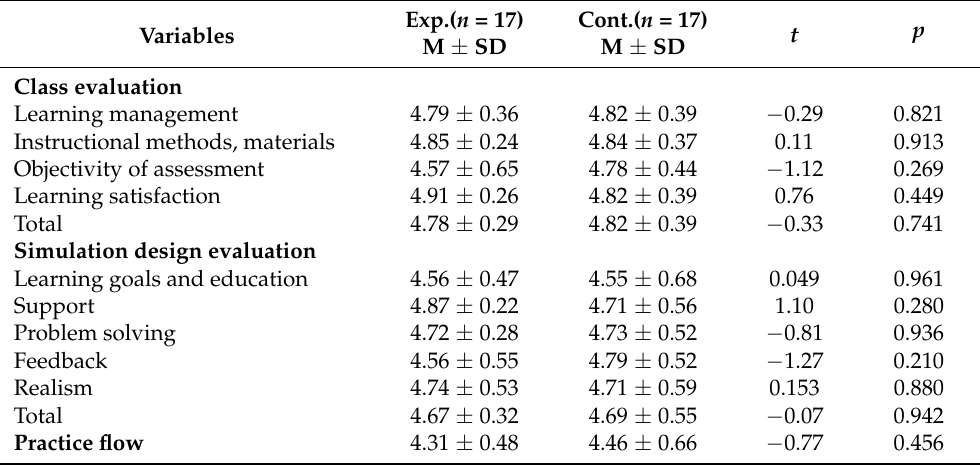
Table 4. Mean Differences of Class Evaluation, Simulation Design Evaluation and Practice Flow between the Experimental and Control Groups ( n =